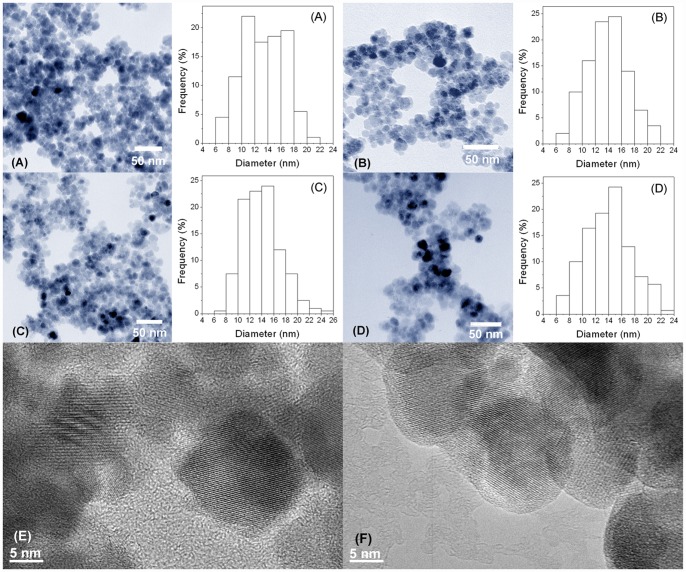
TEM images and the size distributions of nanoparticles.Fe3O4 (A), C3-Fe3O4 (B), C8-Fe3O4 (C) and C18-Fe3O4 (D) nanoparticles, and high resolution TEM images of Fe3O4 (E) and C18-Fe3O4 (F) nanoparticles.